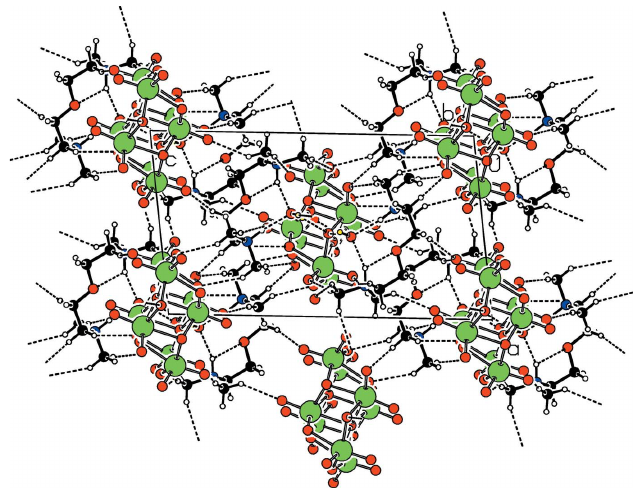
Figure 3 Part of the crystal structure with N—H (cid:2)(cid:2)(cid:2) O, O—H (cid:2)(cid:2)(cid:2) O and weak C— H (cid:2)(cid:2)(cid:2) O hydrogen bonds shown as dashed lines viewed along the [010] direction of the unit cell.